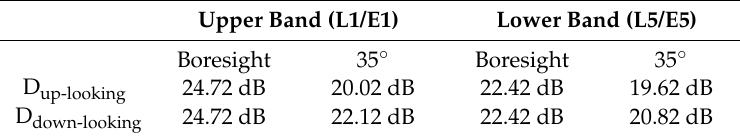
Figure 6. ( a ) Power Spectral Density (PSD), and ( b ) squared auto-correlation function (ACF) of the composite GPS L1 signal with and without considering the IM component (Adapted from [14]). Table 3. Average antenna array parameters used in the estimation of GEROS-ISS experiment performance.